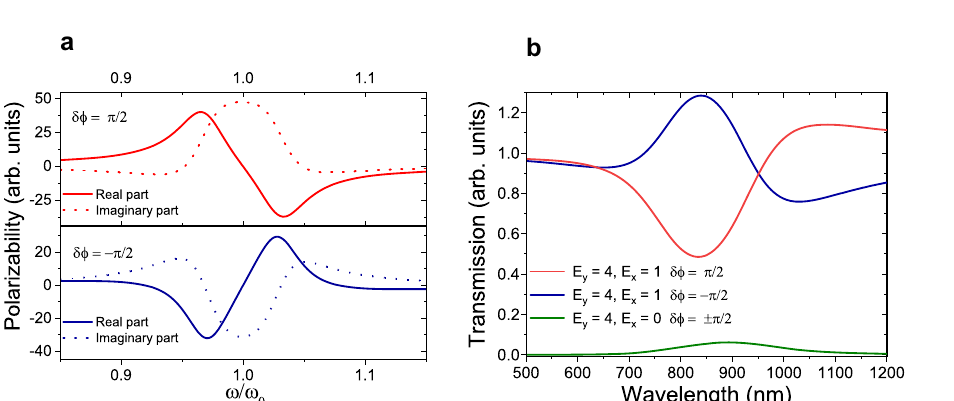
Fig. 1 Polarizability of coupled spheroidal nanoparticles and calculated transmittance of the meta-molecules. a Real (solid lines) and imaginary (dotted lines) parts of polarizability of a spheroidal NP probed by a signal beam while nearly coupled to another orthogonally oriented identical NP which is excited by a phase correlated control beam. The control beam has either π /2 (upper curves) or − π /2 (lower curves) phase difference with respect to the signal beam. Geometrical parameters of a = 70 nm and L = 0.0267 are used for the NPs with center to center distance of R = 90 nm. b The collective transmission response of the meta-molecules corresponding to δϕ = ± π /2 phase differences (blue and red curves) of the control beam. The green curve shows the leakage of control beam to the signal channel when signal is